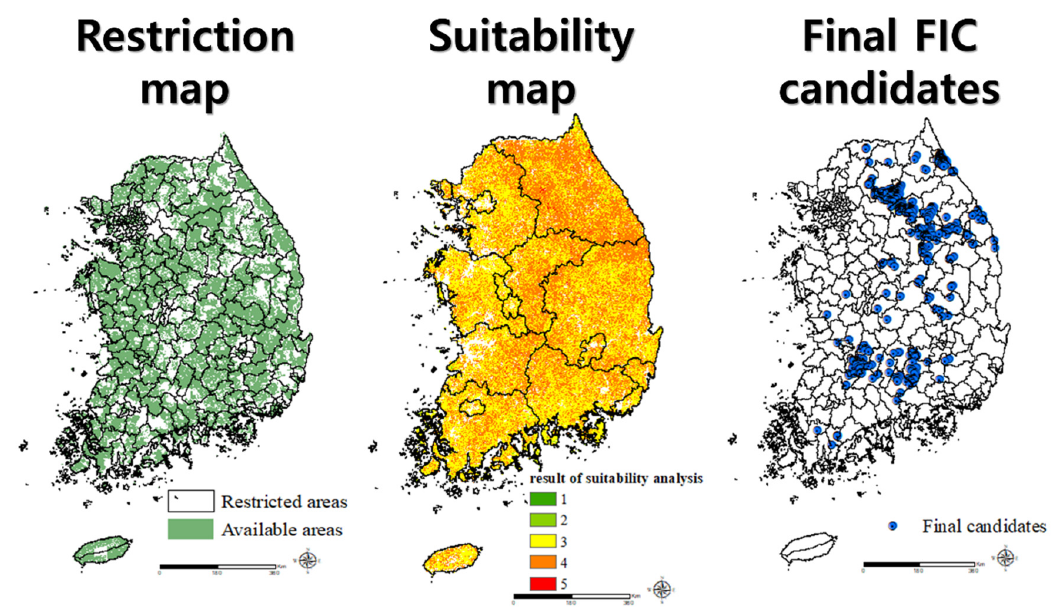
Figure 5. Identified locations of forest industry clusters candidates using developed restriction and suitability models.